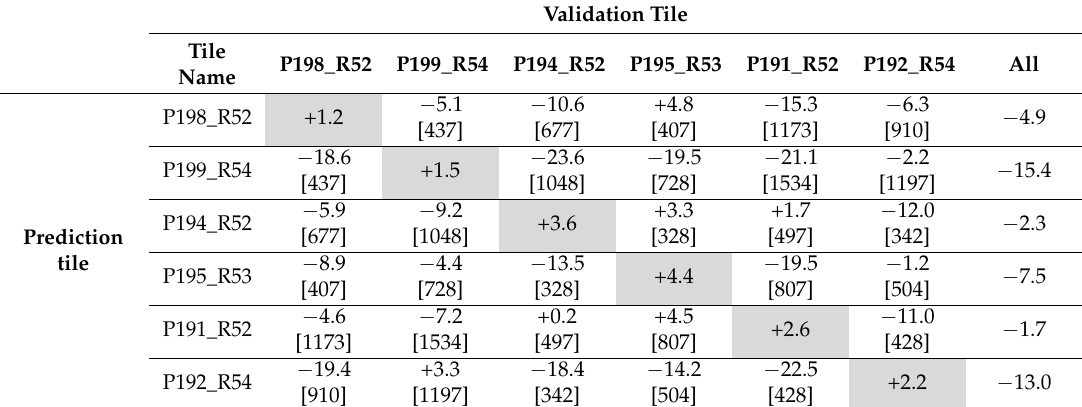
Table 4. Comparison of MAE values: Negative (positive) values indicate higher (lower) MAE when using the prediction tile for modeling the validation tile instead of all six tiles. The column “All” refers to the case that all prediction tiles were modeled and used for the comparison. Gray fields highlight differences of MAE when the entire procedure would have been run on the prediction tile only. The numbers in brackets indicate the distances between the tile centers in kilometers.